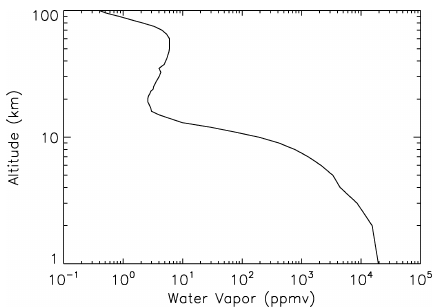
Figure 1. The vertical profile of water vapor mixing ratio used in the MODTRAN5 tropical atmosphere. At the tropopause ( ∼ 18km), the mixing ratio is only a few